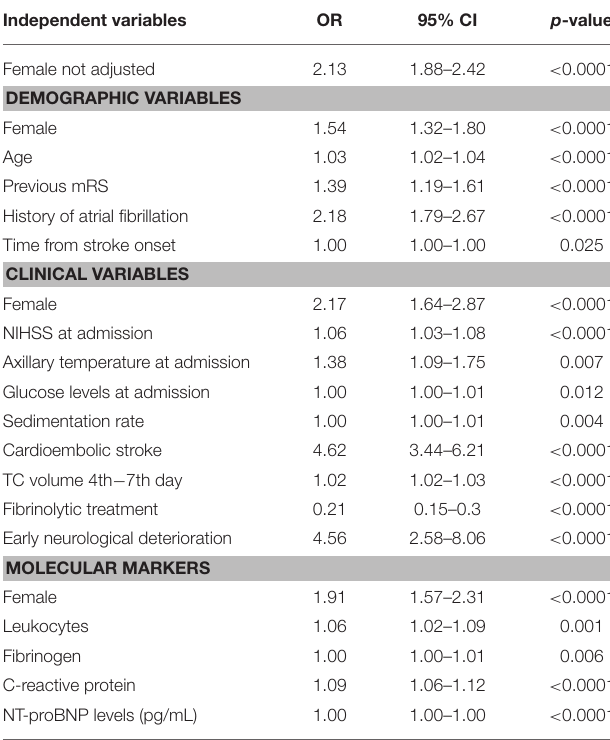
TABLE 3 | Baseline demographic data, clinical characteristics, and molecular markers findings in IS patients with good or poor outcome at 3-months ( n = 4,060).